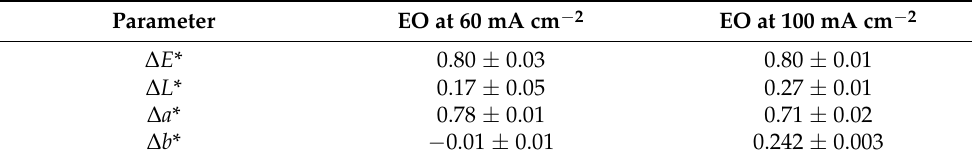
Table 7. Total color difference ( ∆ E *) and differences between L *, a *, and b * obtained from the second reuse cycle.